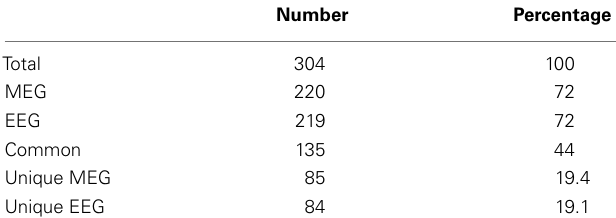
FIGURE 3 | MEG (A) and EEG (B) signals of selected channels and the ECG (C) trace with interictal spikes marked by blue and red bars indicating epileptiform in MEG and EEG in a time-interval of 10s . Averaged interictal MEG (D) and EEG (G) spikes.The magnetic field maps (E) and electric potential maps (H) depicted at labeled time points [blue and